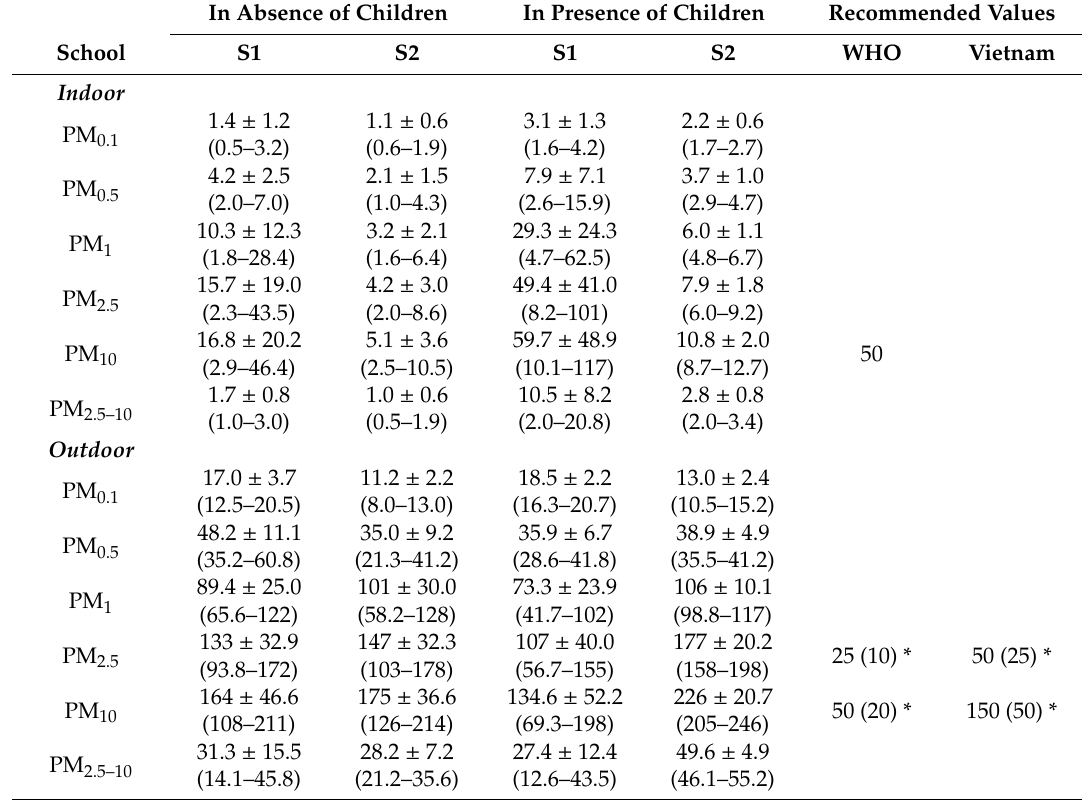
Table 3. Indoor and outdoor size-resolved airborne particle concentrations at S1 and S2 (n = 10 for each parameter, with a total of 80 samples, average ± SD, in parentheses are min–max values). In Absence of Children In Presence of Children Recommended Values School WHO